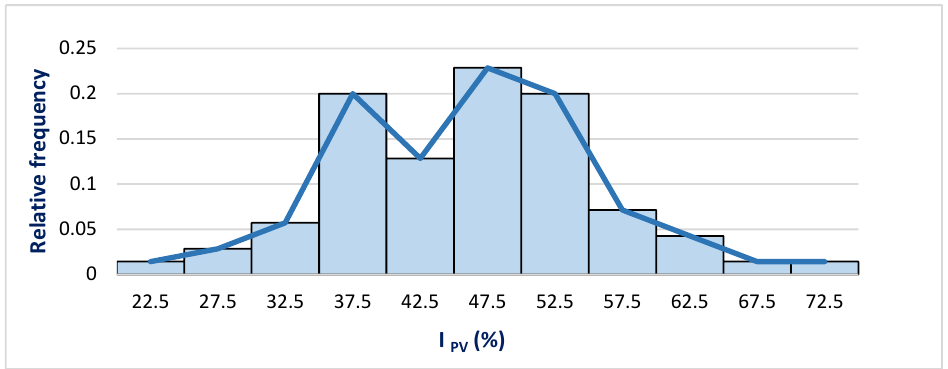
Figure 14. Histogram of the index I PV . Secondly, the percentage ratio of the cost of the power station (defined as the sum of the cost of the transformation center and the inverters) with respect to the total cost of the installation (both in kEUR) is analyzed, I PS . (%). The corresponding histogram (Figure 15) shows that, in all cases, the cost of the power station is less than 45% of the total budget of the PV plant. However, in more than half of the cases analyzed (52.85%), the cost of the power station represents between 5% and 10% of the total budget, and in 28.57% of the cases, between 10% and 15%.